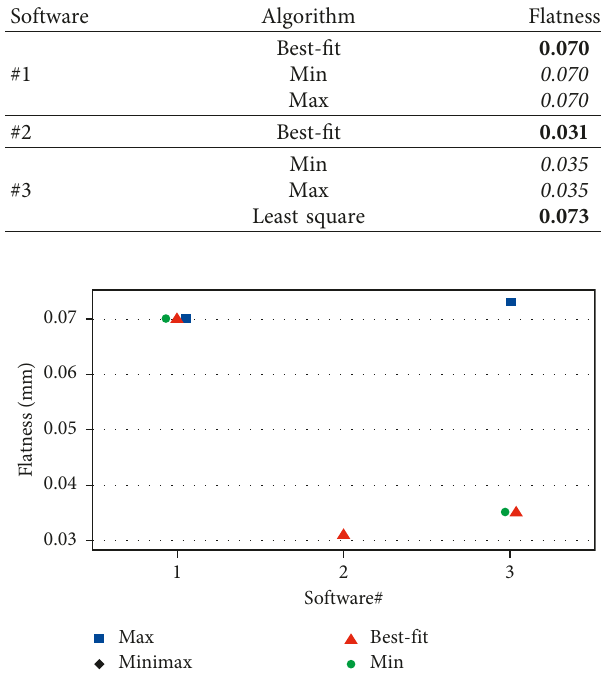
Figure 8: Result of flatness analysis in Plane